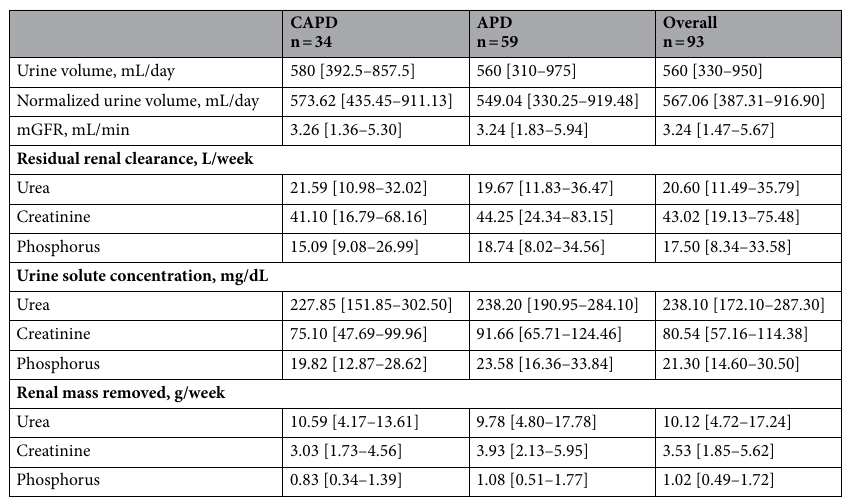
Table 2. Parameters of residual renal function in patients on continuous ambulatory (CAPD), automated peritoneal dialysis (APD) and for pooled